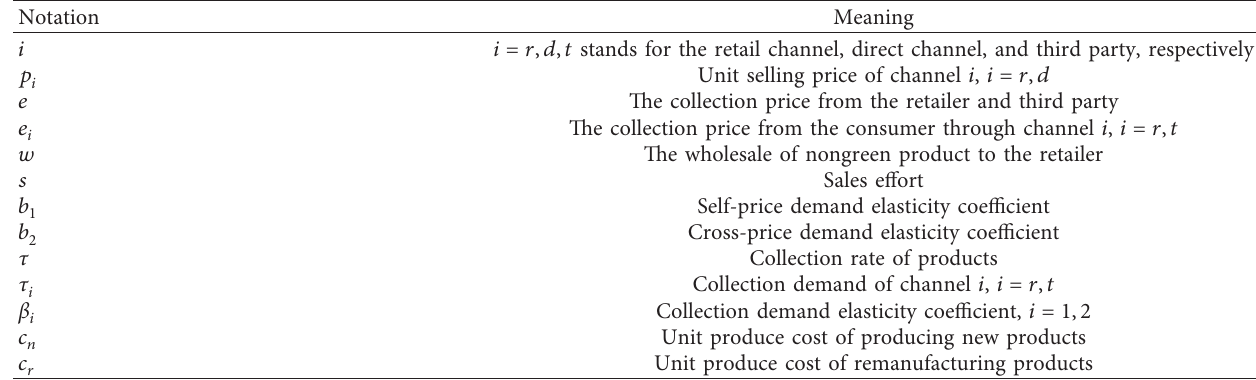
Table 1: Table of